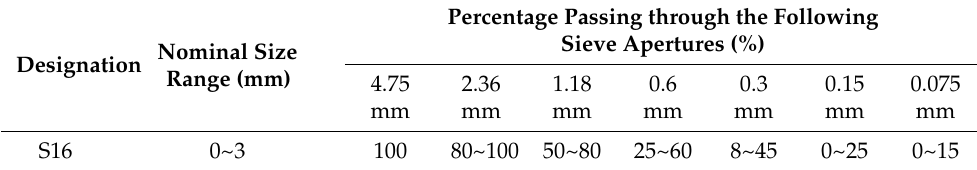
Table 3. Specifications of fine aggregate.